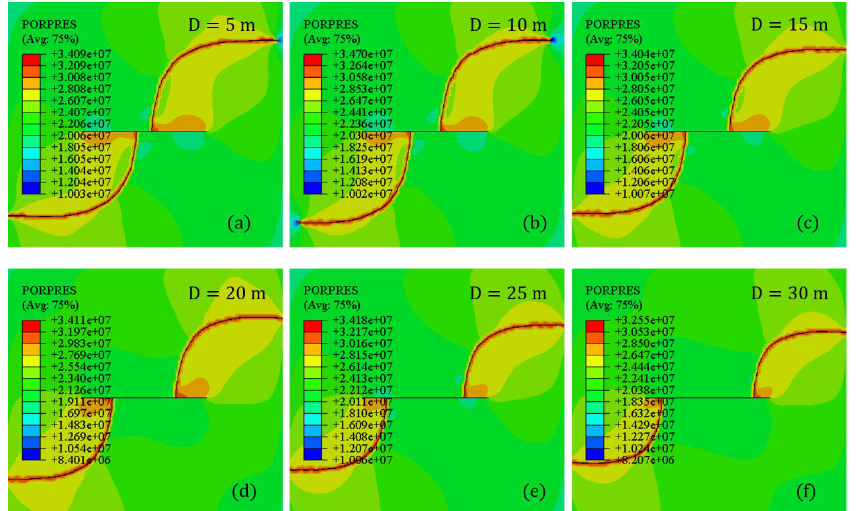
Figure 15. Reorientation behavior of refracturing fractures with different initiation location (PORPRES present the pore-pressure with enrichments: unit is Pa).